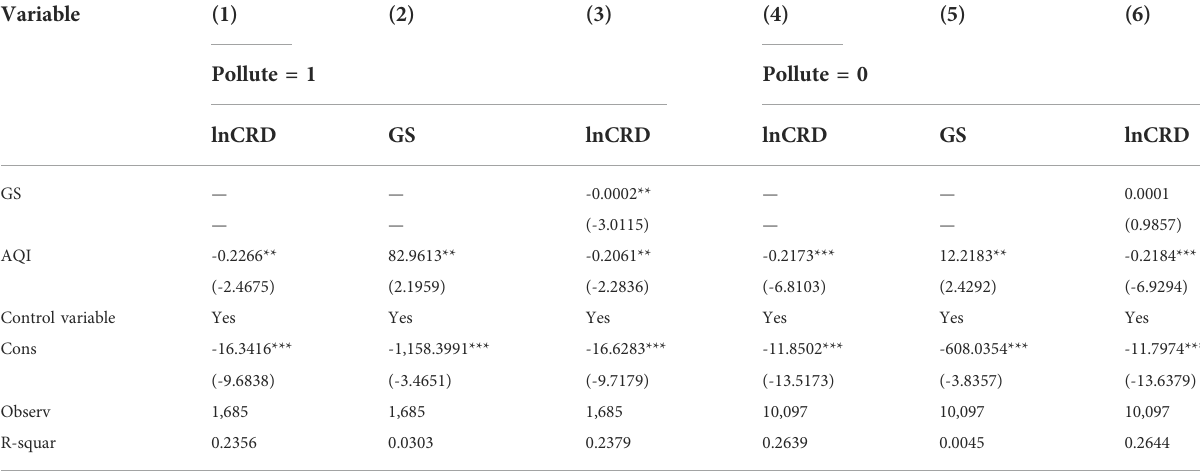
TABLE 11 Heterogeneity analysis of polluting enterprises based on government